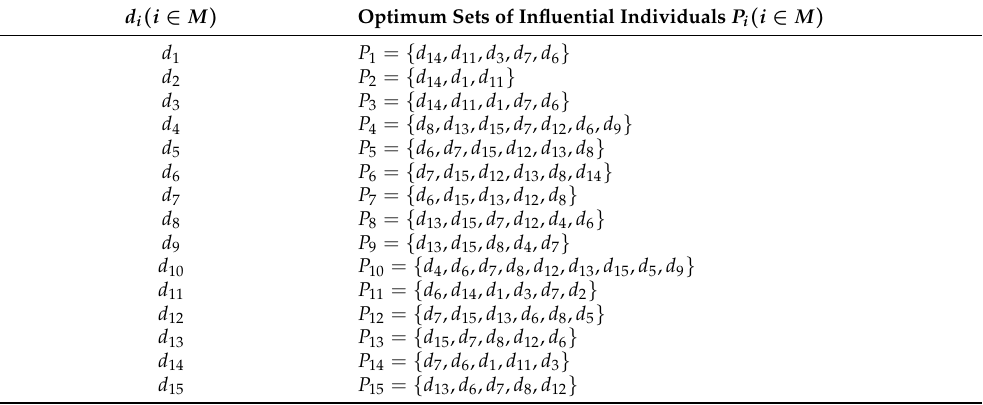
Table 5. The optimum sets of Influential Individuals for 15 Resident Groups. d i ( i ∈ M